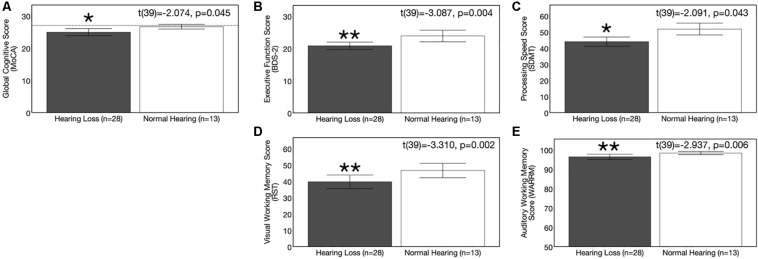
Baseline group differences in cognitive function. Average scores on cognitive measures in the age-related hearing loss group (n = 28) are depicted in gray and average scores for the normal hearing group (n = 13) are depicted in white. Black bars indicate 95% confidence intervals for each group. Asterisks indicate level of significance (**p ≤ 0.01, *p ≤ 0.05). (A) Depicts average global cognitive function on a screening measure (MoCA) for mild cognitive impairment. Higher scores in indicate higher global cognitive function, out of a total score of 30 points. The dotted reference line on the y-axis indicates the cutoff score (≤ 27) indicating risk for mild cognitive impairment. (B) Shows average executive function score (BDS-2). Higher scores in indicate better executive functioning, out of a total score of 27 points. (C) Depicts average processing speed score (SDMT). Higher scores in indicate faster processing speeds in a timed, 90 s digit-symbol matching task. (D) Shows average visual working memory score (RST) in percent words correctly recalled. Higher scores indicate higher visual working memory performance in a dual-task paradigm. (E) Displays average auditory working memory score (WARRM) in percent words correctly recalled. Higher scores indicate higher auditory working memory performance in a dual-task paradigm. The hearing loss group performed more poorly than the normal hearing group across all cognitive outcome measures assessed. Note: Cognitive testing in the hearing loss group was administered in an acutely aided condition to negate confounding effects of audibility on cognitive performance.